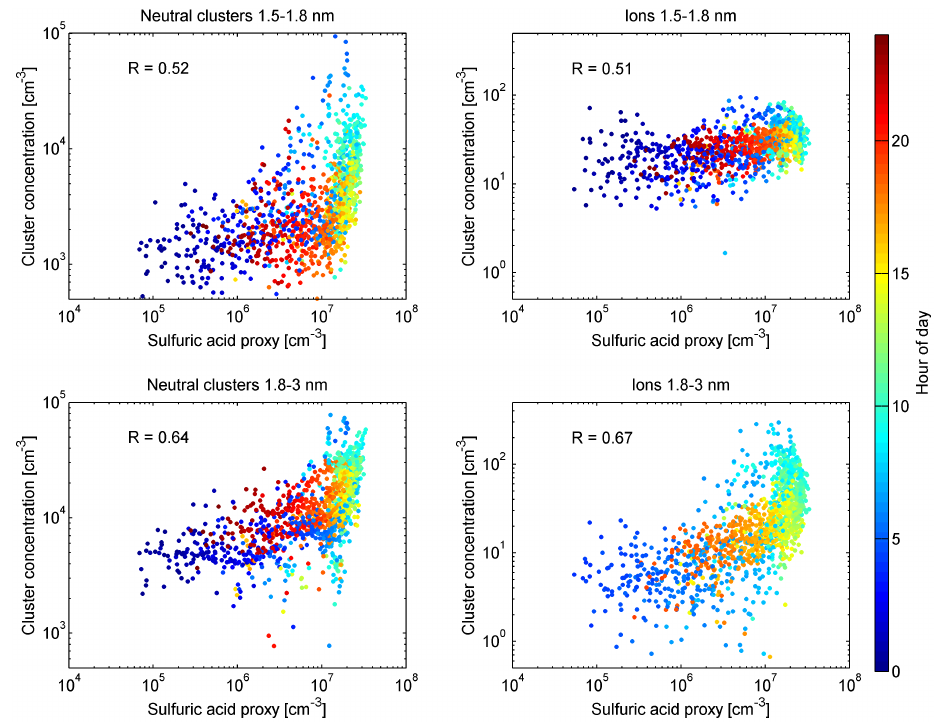
Figure 9. The correlation between the neutral and charged 1.5–1.8 and 1.8–3.0nm clusters and sulfuric acid proxy. The color bar shows the hour of the day. The correlation coefficients ( R ) are presented in the